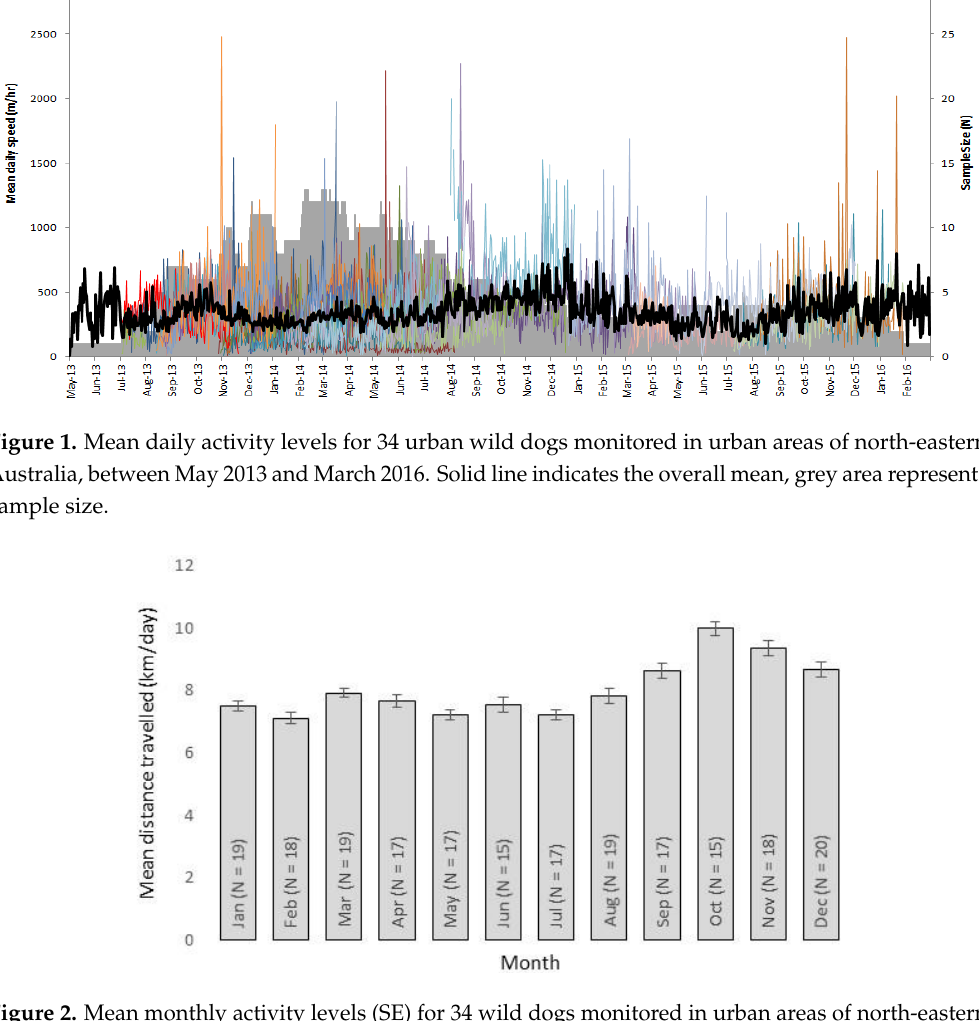
Figure 2. Mean monthly activity levels (SE) for 34 wild dogs monitored in urban areas of north-eastern Australia, between May 2013 and March